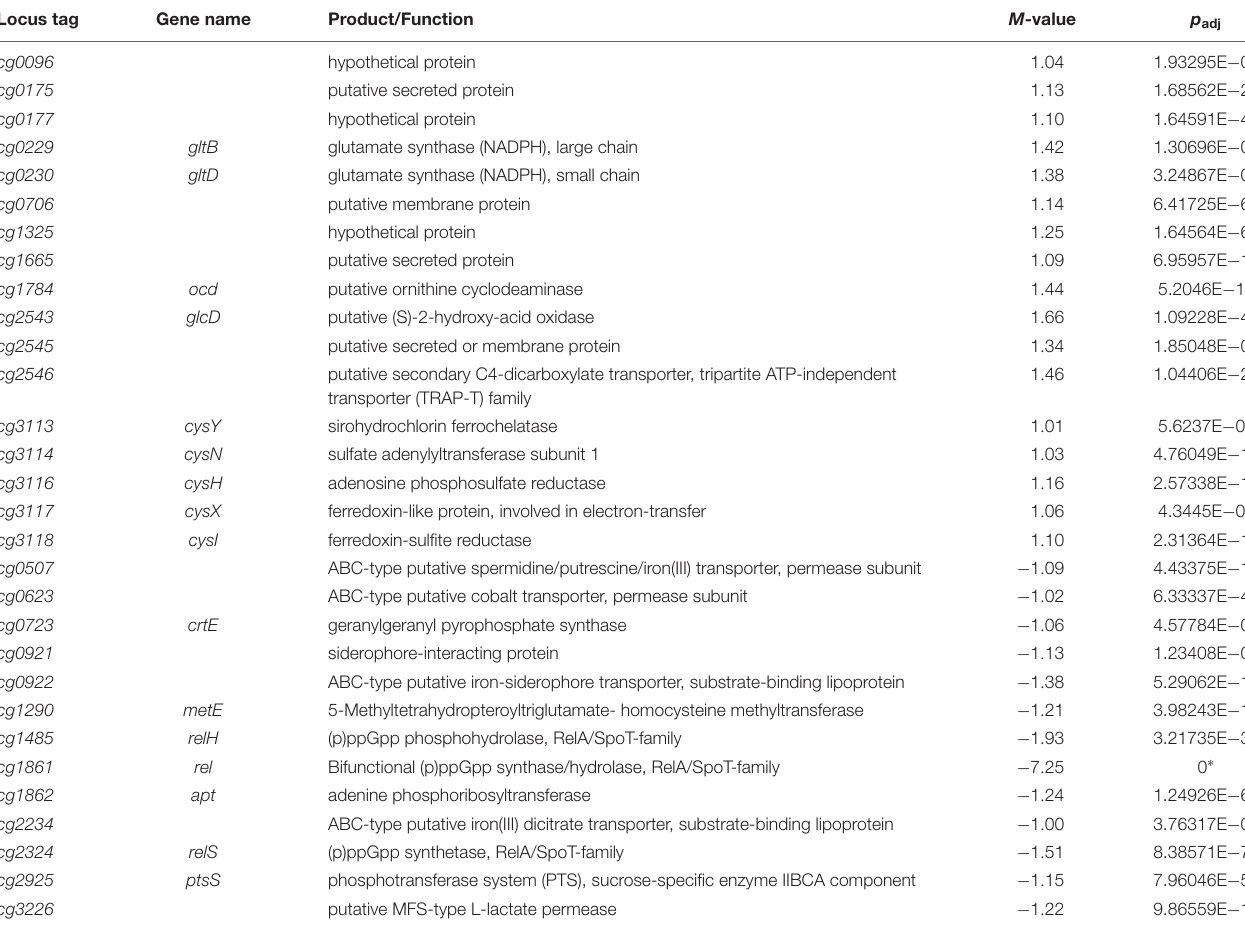
TABLE 2 | Differentially transcribed genes in the early exponential growth phase: C. glutamicum CR099 (cid:49) rel (cid:49) relS (cid:49) relH vs. C. glutamicum CR099. Locus